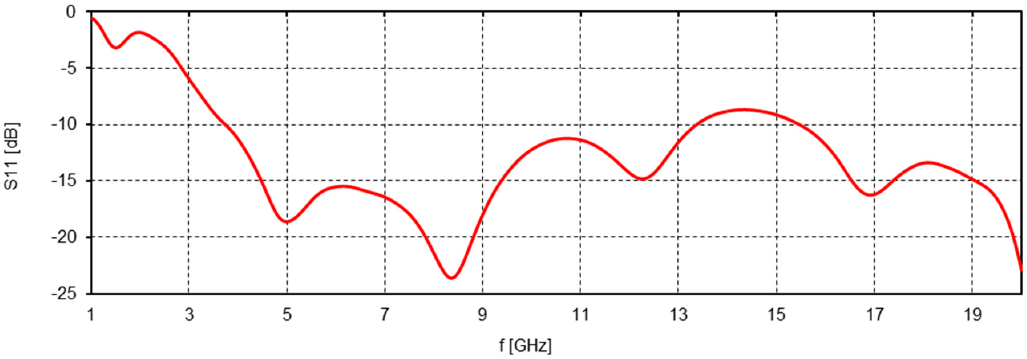
Figure 5. Simulated values of S11 for the antenna with ground based on Minkowski fractal.